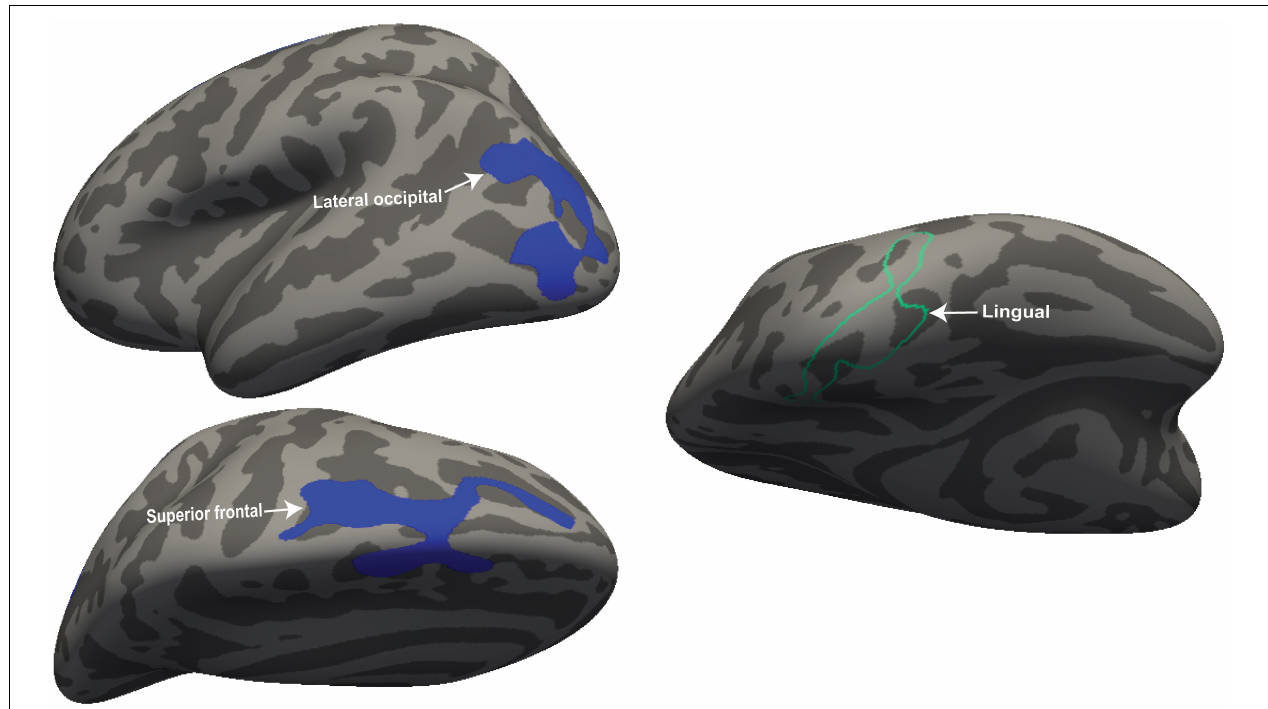
FIGURE 4 | For ME/CFS and HC, a significant cluster from interaction-with-group regressions with “SDS.” The volume cluster of lateral occipital and superior frontal was observed in the left hemisphere and thickness cluster in the lingual gyrus in the right hemisphere. The volume (left hemisphere) is represented with filled blue color whereas thickness (right hemisphere) is represented by unfilled green color. Significant volume and thickness clusters were overlaid on the inflated brain (left and right hemisphere) available in the